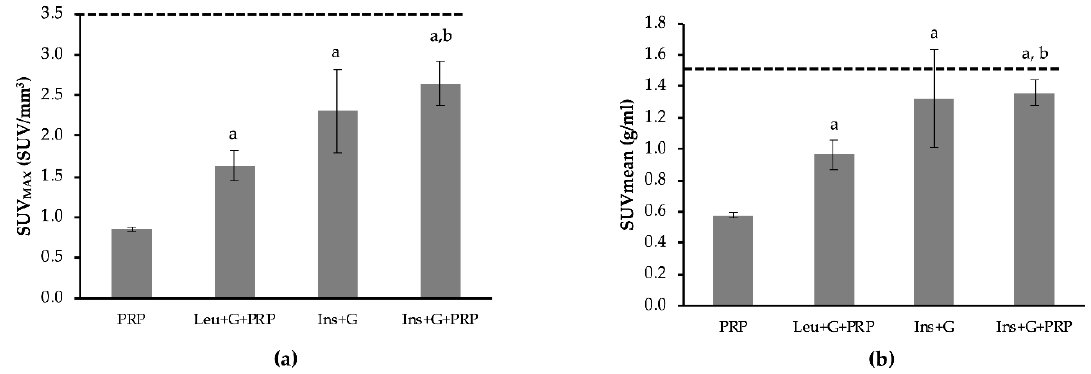
Figure 5. The effect of inhibiting β-adrenergic activation on 2-deoxy-2-(fluorine-18)fluoro- D -glucose ( 18 F-FDG) uptake in paraspinal skeletal muscle. β-adrenergic activation was inhibited by pretreatment with propranolol (PRP). Dashed line represents SUV MAX for control/untreated animals. Following pretreatment with PRP, mice were either untreated (PRP), or treated with leucine and glucose (Leu + G + PRP) or insulin and glucose (Ins + G + PRP). SUV is also reported for insulin and glucose together, without PRP (Ins + G). (a) Group mean data for the maximum SUV (SUV MAX , units in SUV/mm 3 ) was calculated for paraspinal skeletal muscle for each treatment group. (b) Group mean data for the average SUV across the entire tissue (SUVmean, units in g/mL). Data are expressed as mean ± the SEM. A one-way analysis of variance was performed followed by a Fisher LSD post-hoc. a, denotes significant difference compared to PRP; b, denotes significant difference compared to Leu+G+PRP ( p ≤ 0.05). n = 7 for PRP and Leu+G+PRP. n = 3 for Ins+G and Ins+G+PRP.